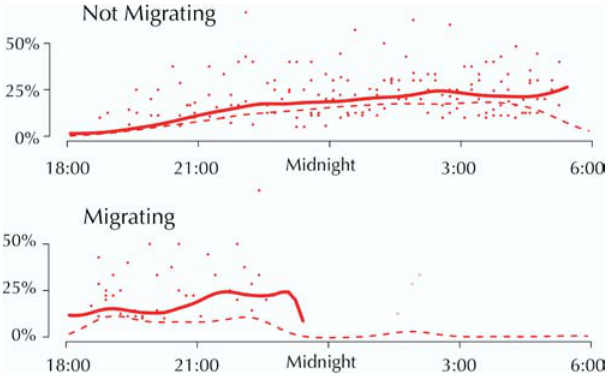
Figure 4. REM Sleep across the Dark Phase REM sleep as a proportion of total sleep time is plotted for every 10- min period during the dark phase for birds in nonmigrating ( n = 5) and migrating ( n = 8) states. The individual dots represent the average for each 10-min period; the solid line is a spline fit to these data. The dashed line represents the absolute amount of REM sleep, as a percentage of recording time. Note that the fit for the migrating birds is truncated, not only because very few periods after midnight had any REM sleep, but also because no point after midnight was based on more than one bird. DOI: 10.1371/journal.pbio.0020212.g004